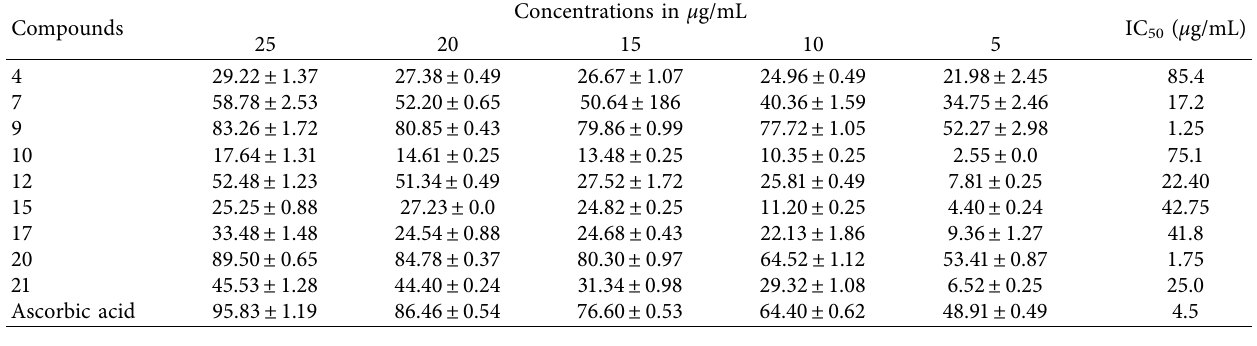
Table 2: The % inhibition of the synthetic compounds.